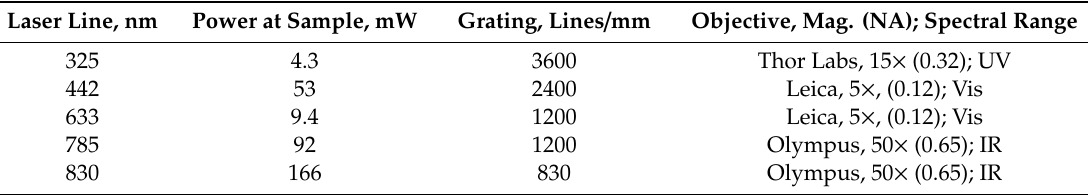
Table 2. Setup of the Raman system.